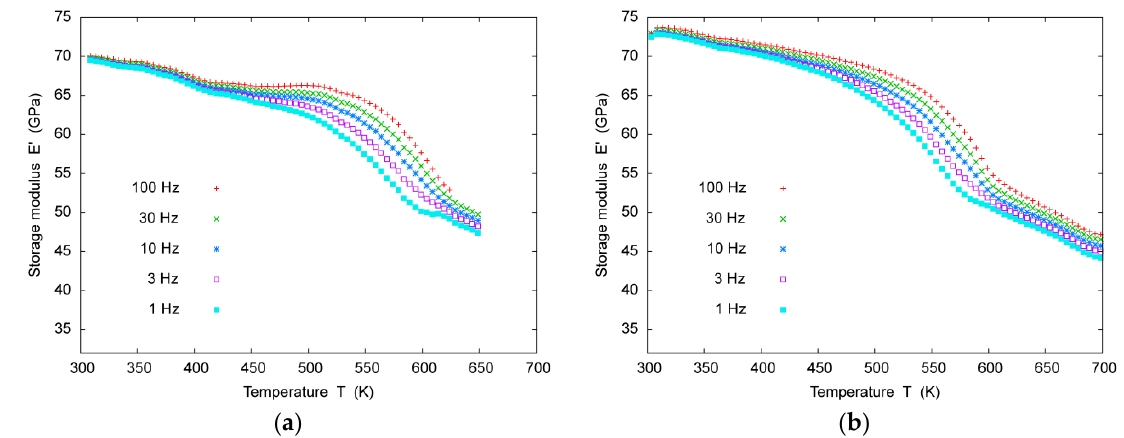
Figure 1. Storage modulus E ’ vs. temperature T from dynamic-mechanical analyzer tests at frequencies ranging from 1–100 Hz: ( a ) for pure Al in the H24 temper, from room temperature (RT) to 648 K; ( b ) for pure Al, from RT to 723 K.